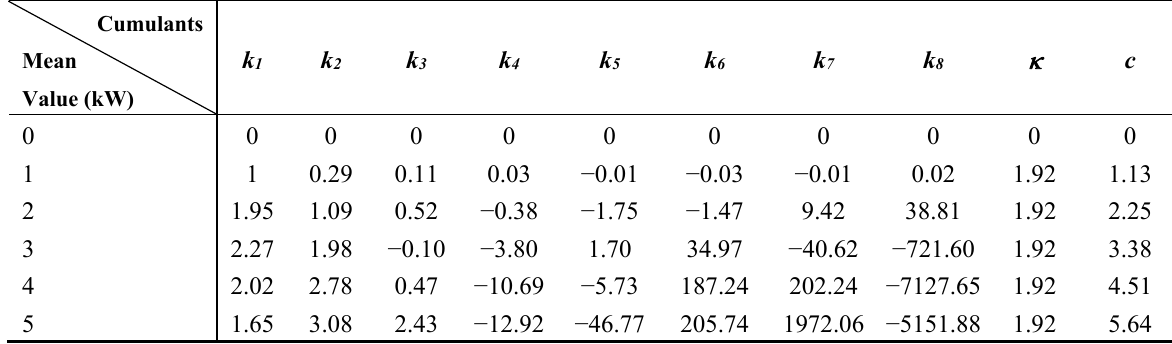
Table 2. Cumulants of PV power levels with different values of κ and c .